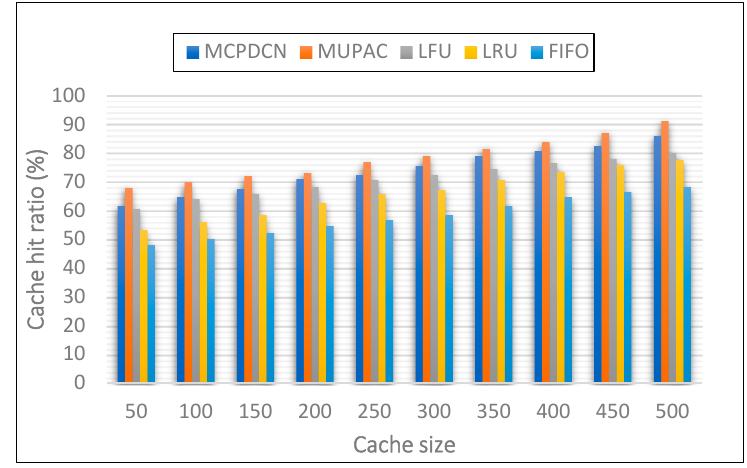
Figure 8. Cache hit ratio comparison.